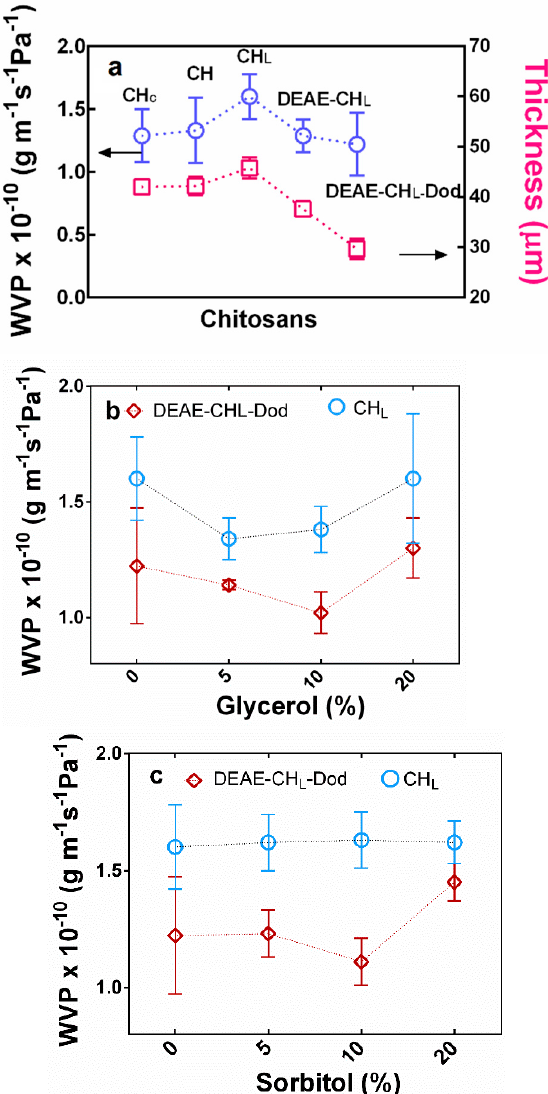
Figure 6. Water vapor pressure and thickness of films prepared with chitosan and its derivatives. ( a ) without plasticizer and with increasing percentages of ( b ) glycerol and ( c ) sorbitol. For statistical analysis, please see Tables 3 and 4 ( p <0.05). Table 3. Average water vapor permeability of chitosan films prepared with increasing percentages of glycerol and sorbitol at a relative humidity of 53%.